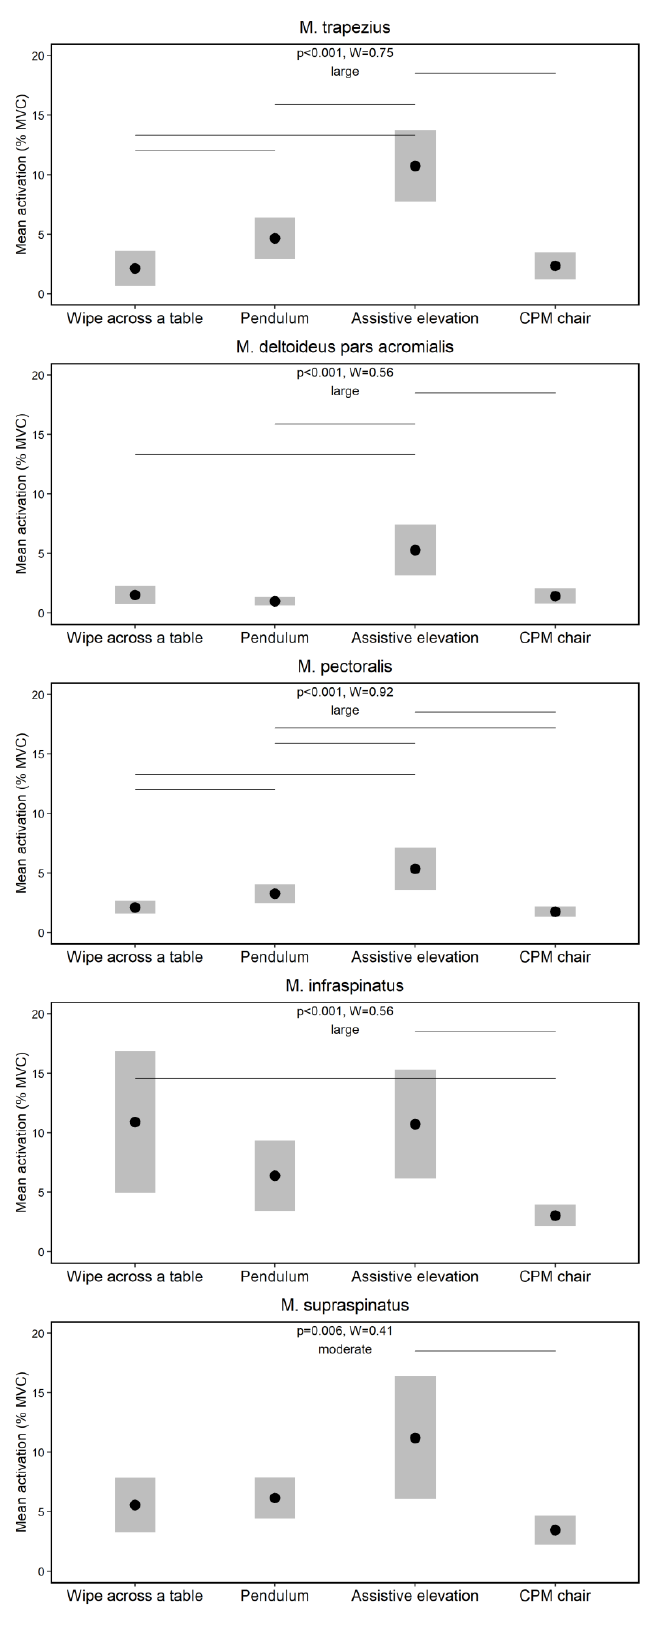
Figure 6. Effects of the physiotherapeutic exercises on the neuromuscular activity of the shoulder muscles. Note: Diamonds and bars indicate mean activations (%MVC) and 90% confidence intervals, respectively. Horizontal lines indicate significant post-hoc